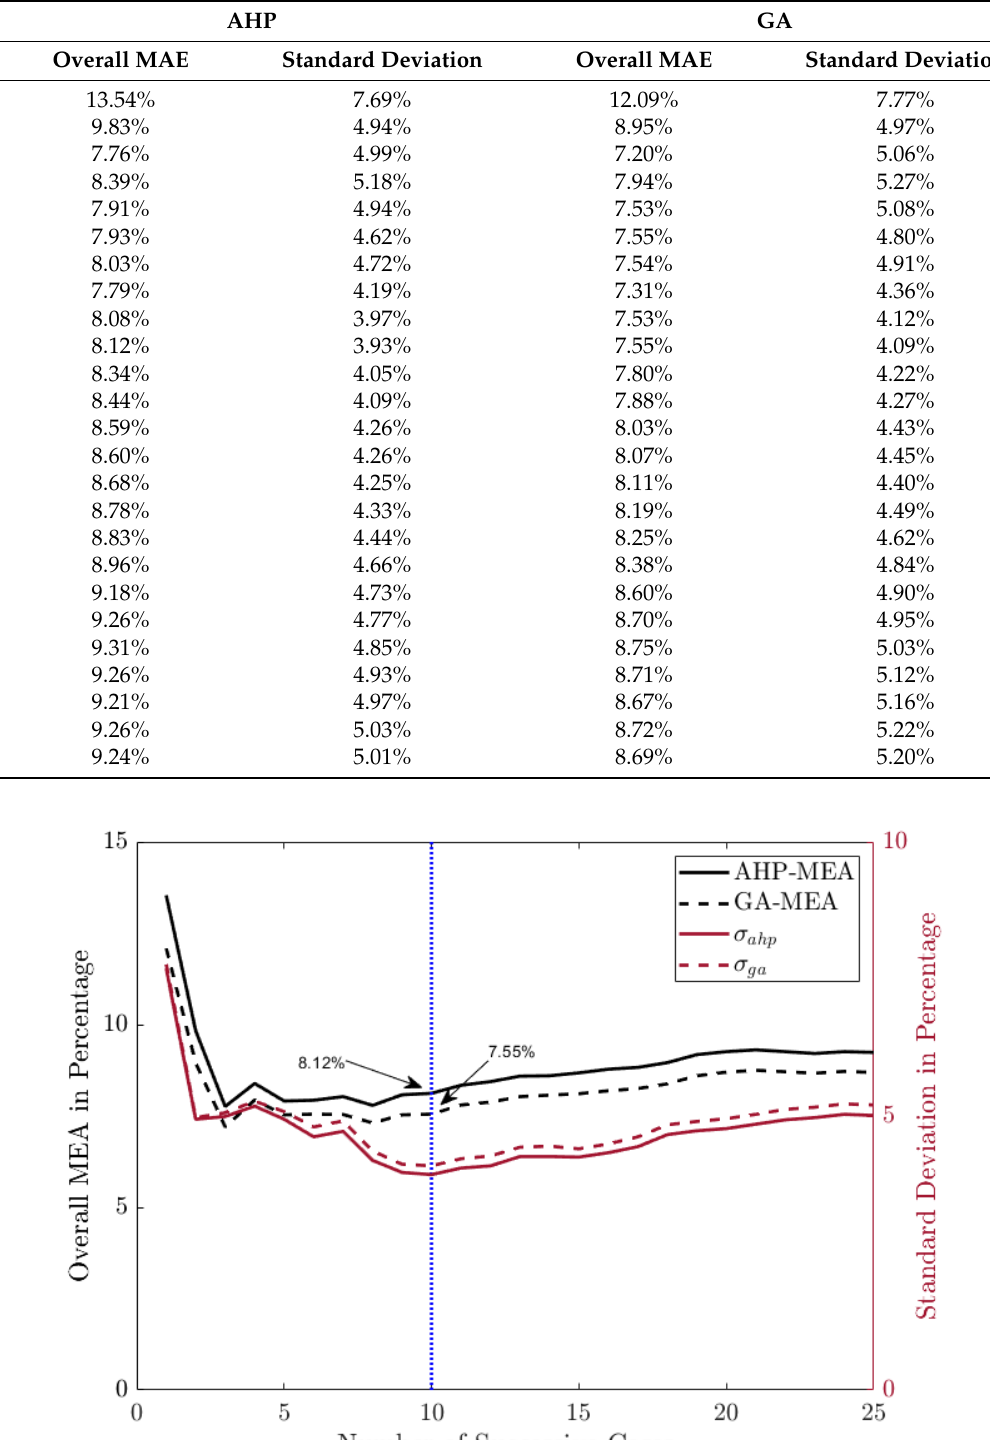
Figure 7. Overall MAE vs. Number of Successive Cases [59] .